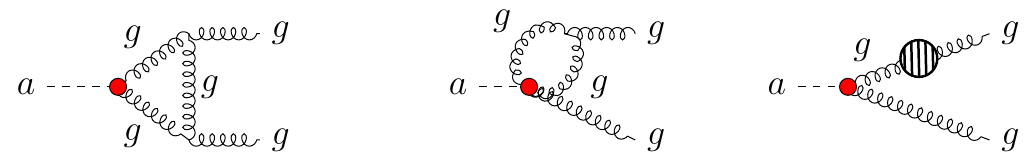
˜ G interaction. The blob in the